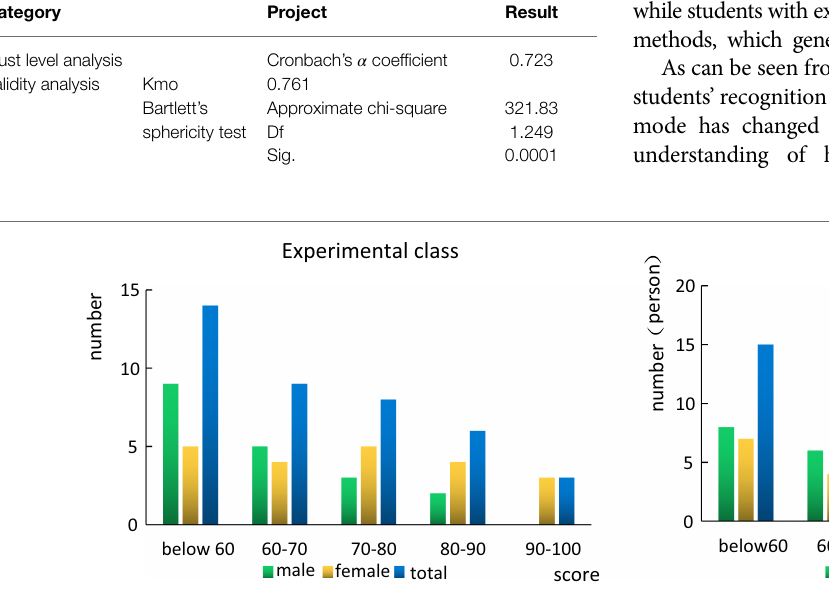
FIGURE 7 | Comparison of the scores of the experimental class and the control class before the experiment.